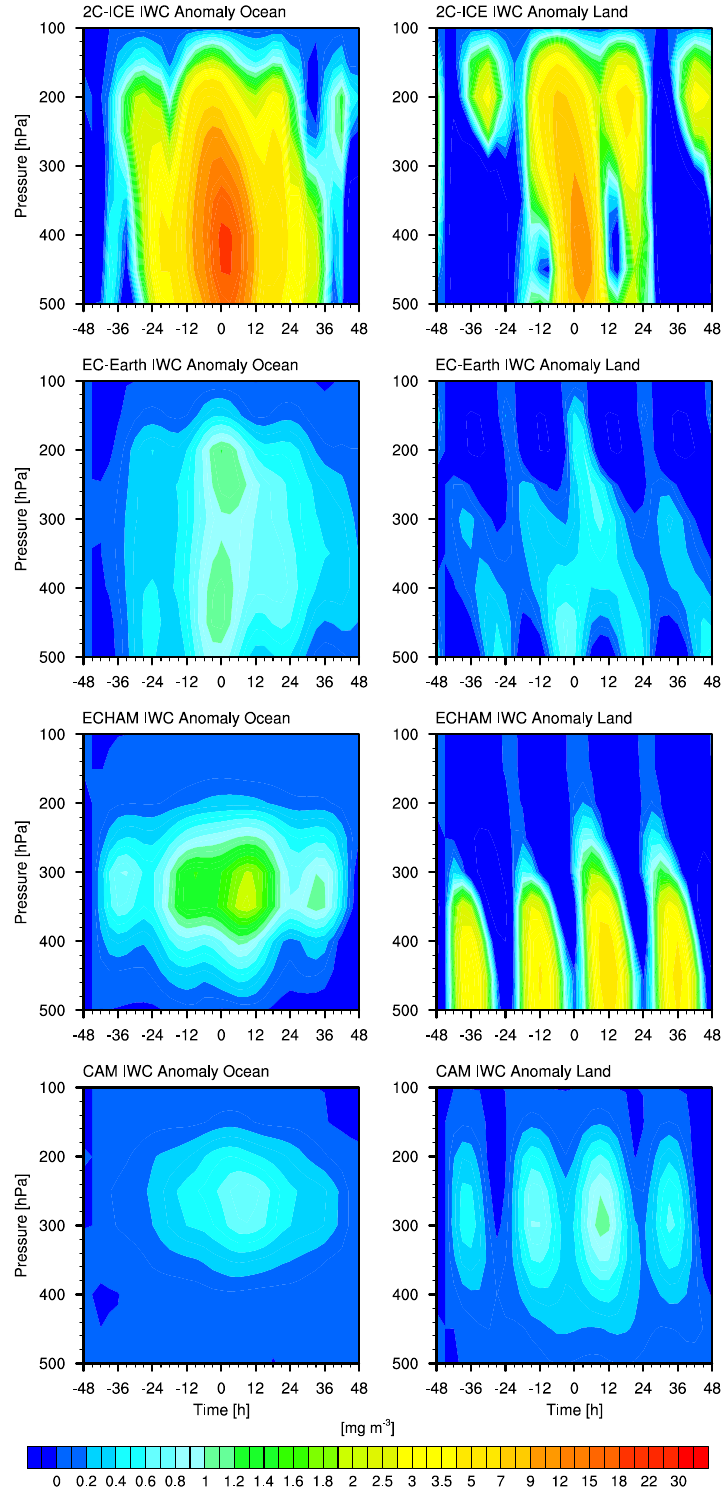
Figure 9. Ice water content (IWC) anomaly for ocean-based (left column) and land-based (right column) systems. The data are plotted for the area ± 3 ◦ latitude, ± 10 ◦ longitude, and ± 48h from the centre point of peak rain rate (RR). The results are smoothed using a 12h running mean. The background state is the spatio-temporal mean of the earliest four time